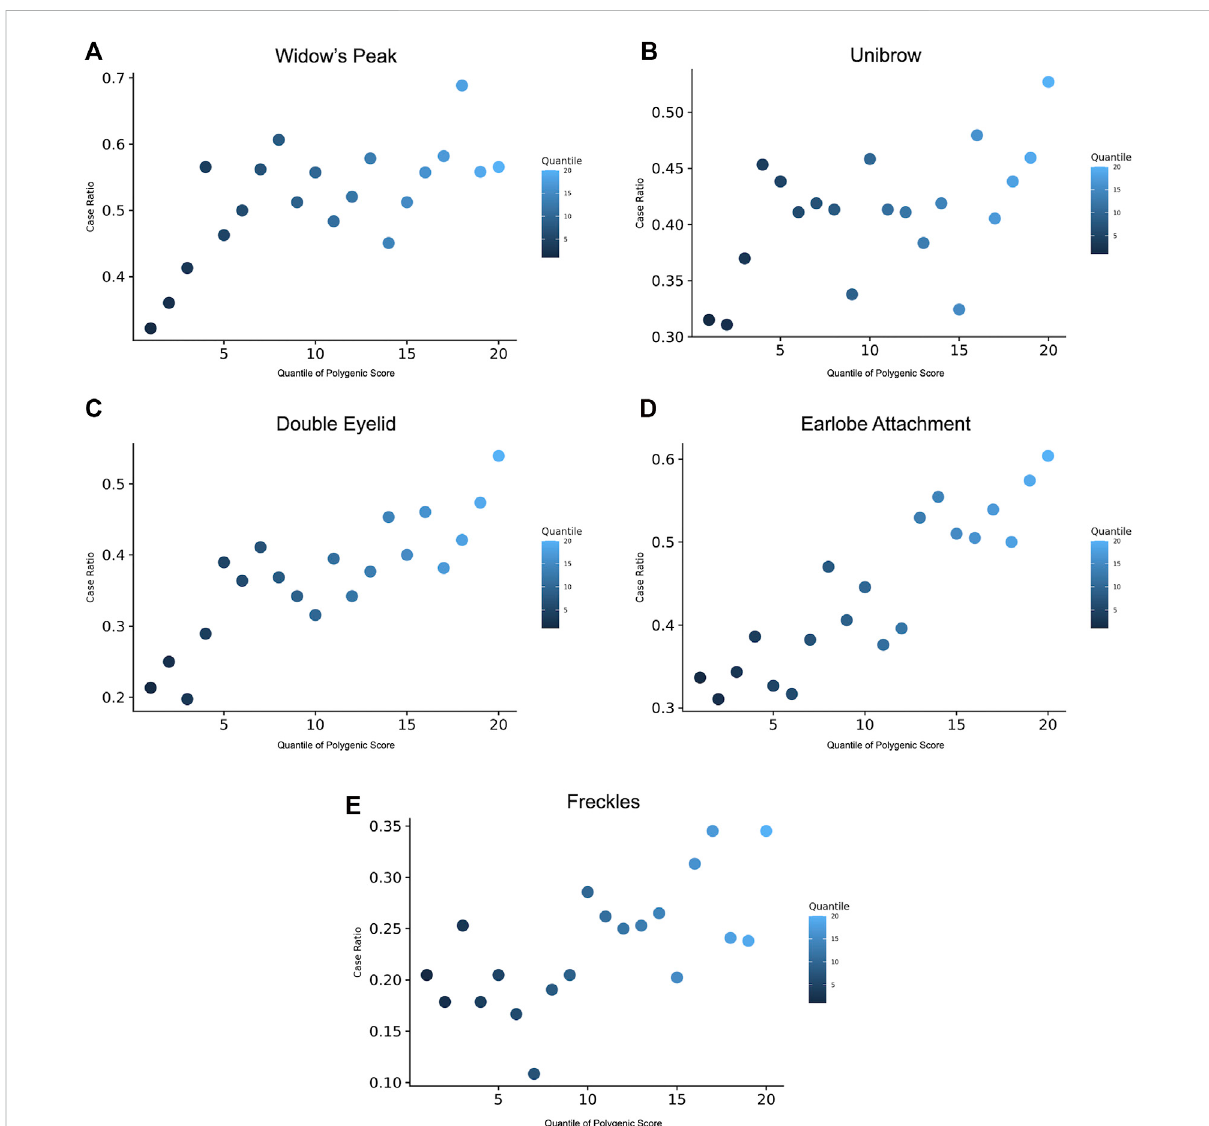
FIGURE 4 Prevalence of the traits according to the GPS quantile. 20 groups of the validation were derived based on the percentile of the GPS. Prevalence of phenotype displayed for the risk of (A) widow ’ speak, (B) unibrow, (C) double eyelid, (D) earlobe attachment, and (E) freckles, within each quantile. GPS, genome-wide polygenic